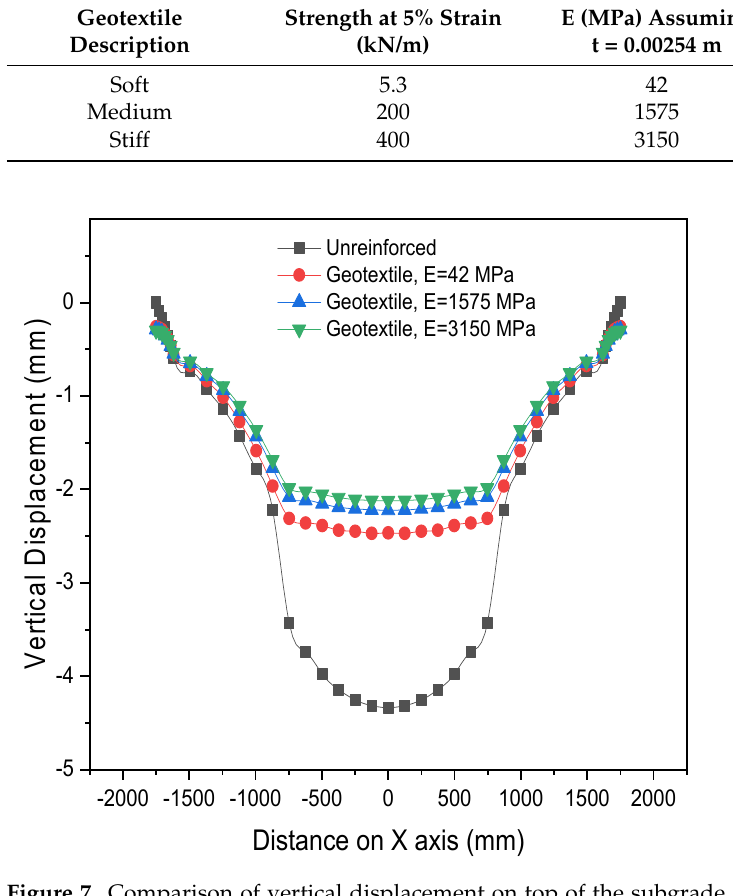
Figure 7. Comparison of vertical displacement on top of the subgrade for geotextiles of varying elastic modulus.